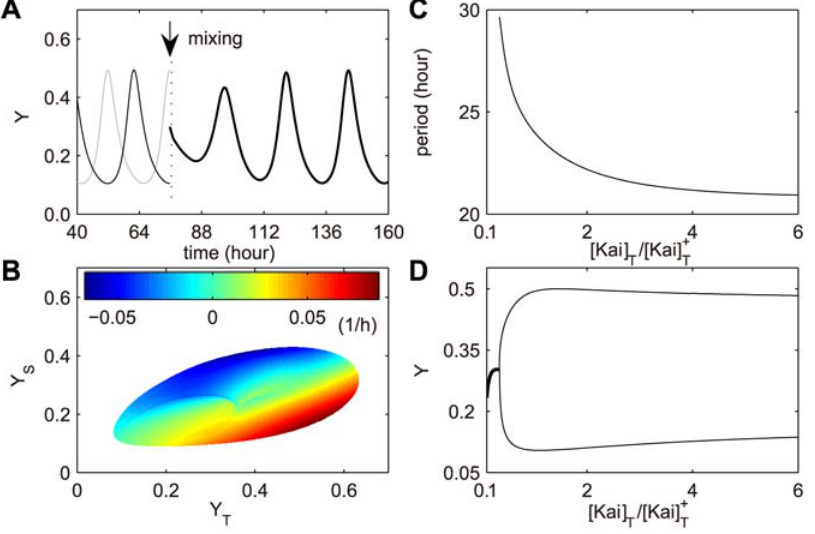
Figure 7. Robustness in Kai reaction network. (A) Resilience of Kai oscillator examined by mixing two anti-phased (trough and peak) samples with equal amount. The thin black and grey lines are the applied samples, and the bold black line the mixture. (B) Contour map of the initial reaction rate of Y after equal-amount sample mixing. The contour map is established in the interior region of the limit cycle of Y S and Y T . (C–D) Bifurcation analysis for the period (C) and amplitude (D) of KaiC phosphorylation by varying total Kai protein concentration. [Kai] + T is the concentration of the standard mixture.